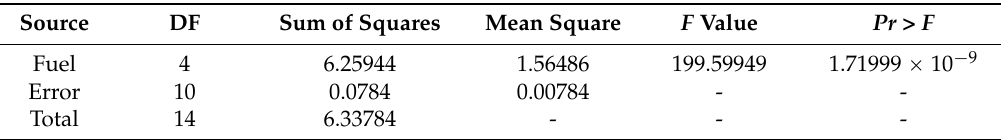
Table 5. ANOVA for the heating value.